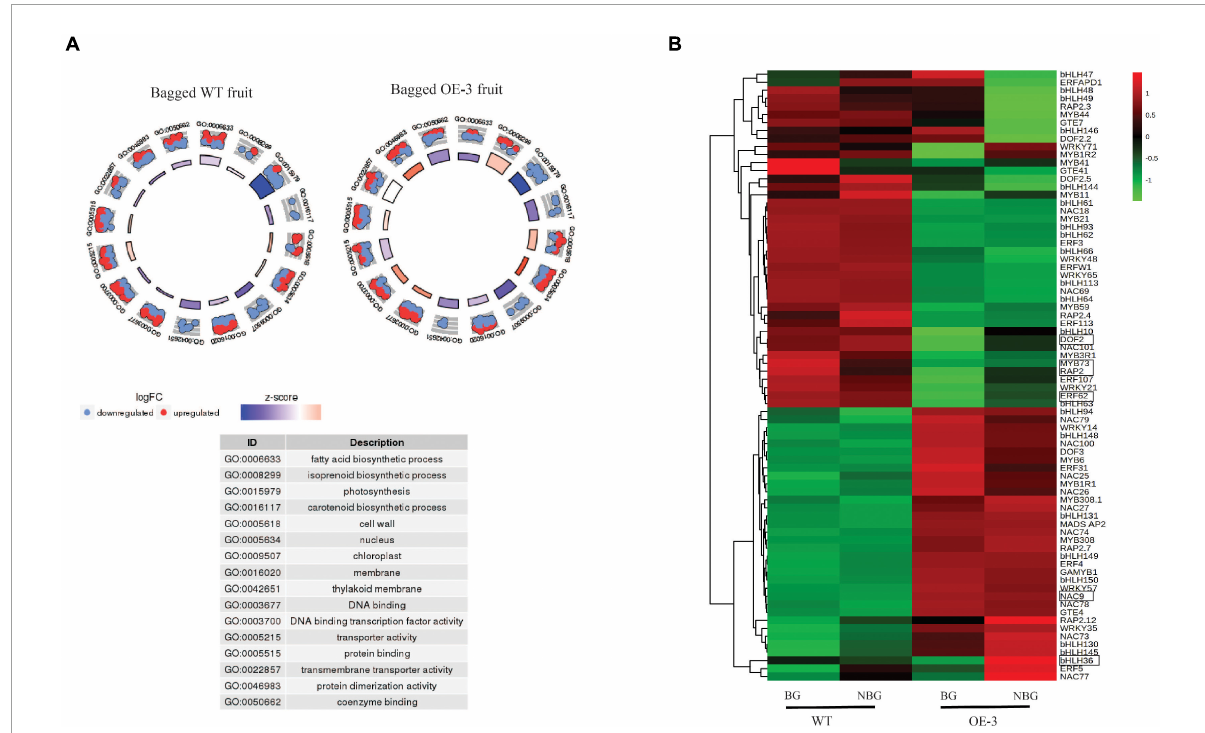
FIGURE7 Differentially expressed genes (DEGs) in bagged apple fruit. (A) Go Plot R of DEGs in bagged fruit of WT and OE-3 fruit. The scatter plots show log 2 fold change (logFC) for each gene under the gene ontology (GO) number. Red dots indicate upregulated genes and blue dots show downregulated genes. The z -score bars are a measure of the extent to which each identified process is upregulated or downregulated. (B) Heat map of differentially expressed transcription factor genes in bagged fruit. Clustering done using the average expression values of three biological replicates of bagged (BG) and non-bagged (NBG) fruit of WT and OE-3 transgenic line. Green to red color gradients indicate low to high relative gene expression. The highlighted TFs are common to the bagging and fruit development ( Figure 5A ) data